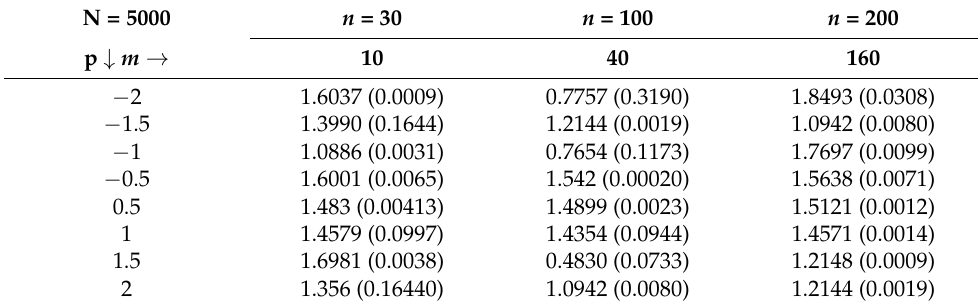
Table 8. Bayesian estimators and PR (in brackets) under the entropy loss function.